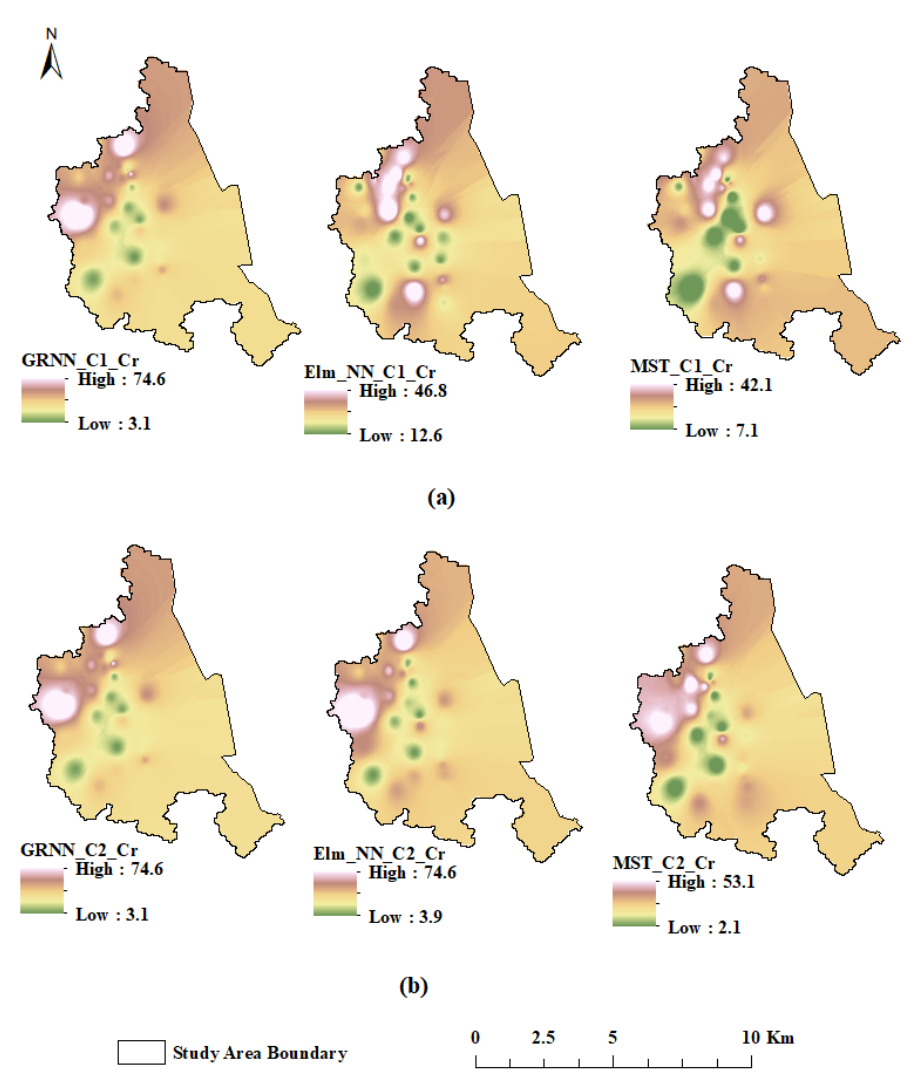
Figure 11. Predicted spatial analysis for both ( a ) C1 and ( b ) C2 combination.